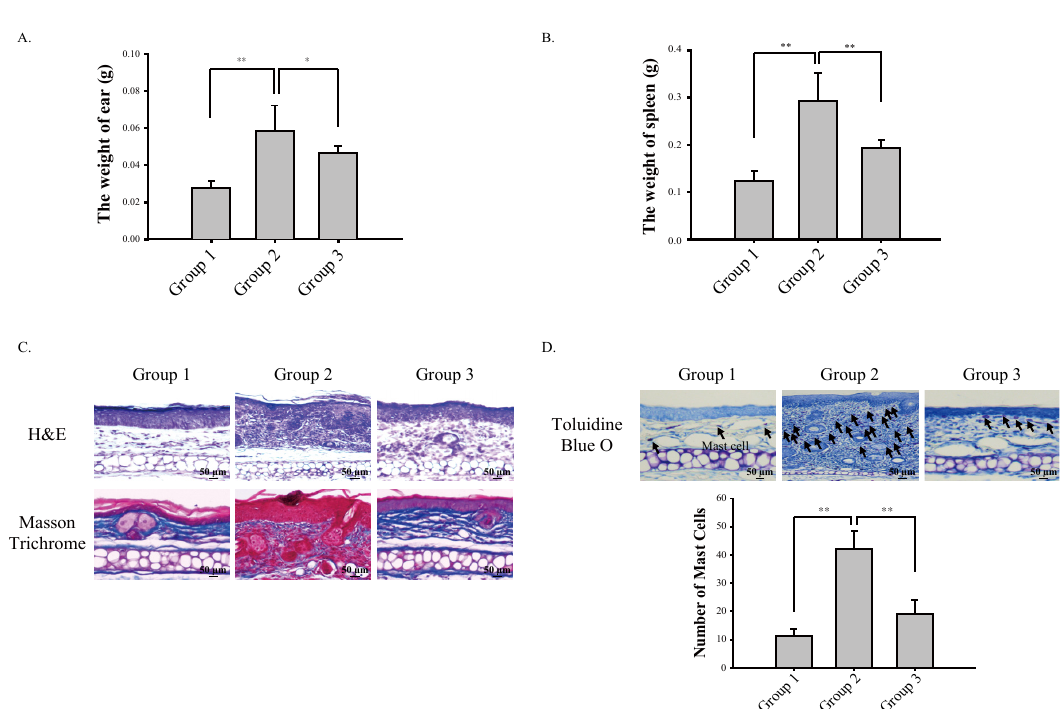
Figure 2. Cardamonin suppresses oxazolone-induced atopic dermatitis by maintaining the integrity of the skin and inhibiting the infiltration of mast cells. ( A ) Cardamonin inhibits an increase in the weight of ear induced by oxazolone. At sacrifice, mouse ears were excised and their weight was measured. Asterisks indicate a statistical significance of * p < 0.05 and ** p < 0.01. ( B ) Topical application of oxazolone onto the ear of mouse induces splenomegaly in mice, which is inhibited by cardamonin. At sacrifice, the spleen of mouse was excised and the weight was measured. Asterisks indicate a statistical significance of ** p < 0.01. ( C ) Cardamonin inhibits oxazolone-induced destruction of connective tissues in the ear of mouse. Gross morphology of mouse skin tissues in the ear are stained by H&E staining (upper panel) and the collagens in connective tissues are stained by Masson trichrome staining (lower panel). ( D ) Cardamonin inhibits oxazolone-induced infiltration of mast cells into the skin. Mast cells are stained by Toluidine Blue O staining (Upper Panel) and the number of mast cells under the bright field was counted (Lower Panel). Asterisks indicate a statistical significance of ** p < 0.01.